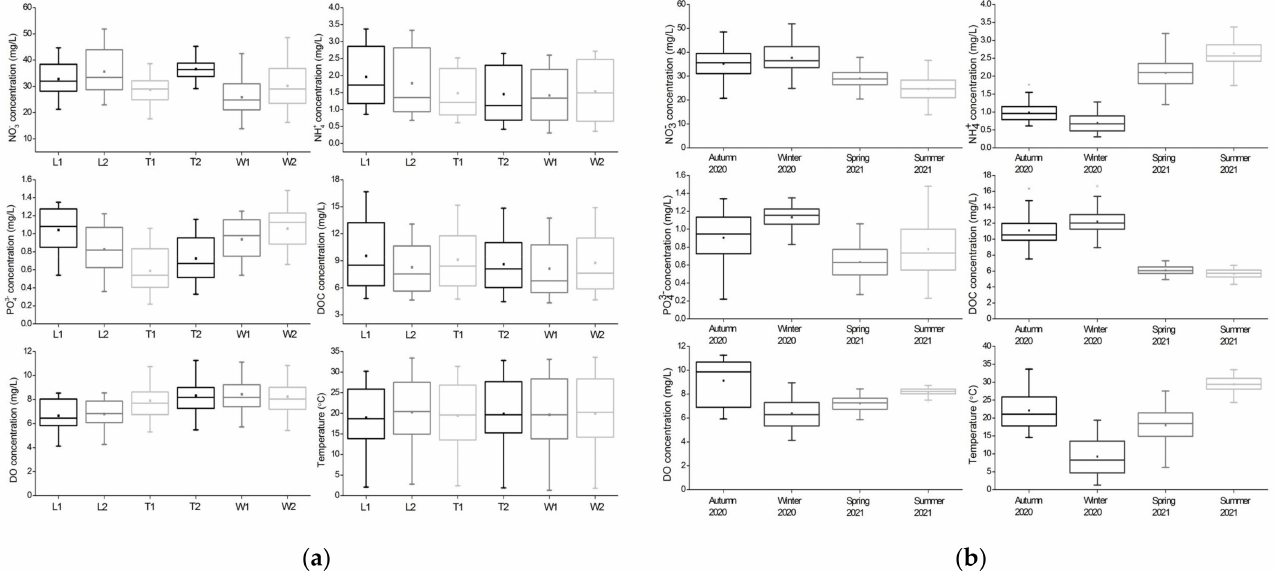
Figure 3. ( a ) Concentrations of nutrients and DO and water temperature across sampling sites. Each box contains all data points from sampling events during the study period. The concentrations of NO 3 − , NH 4+ and PO 43 − across the three rivers were significantly different. ( b ) Concentrations of nutrients and DO and water temperature in four seasons during the study period. Each box contains data points from all sampling sites in the corresponding season. The concentrations of all nutrients changed significantly